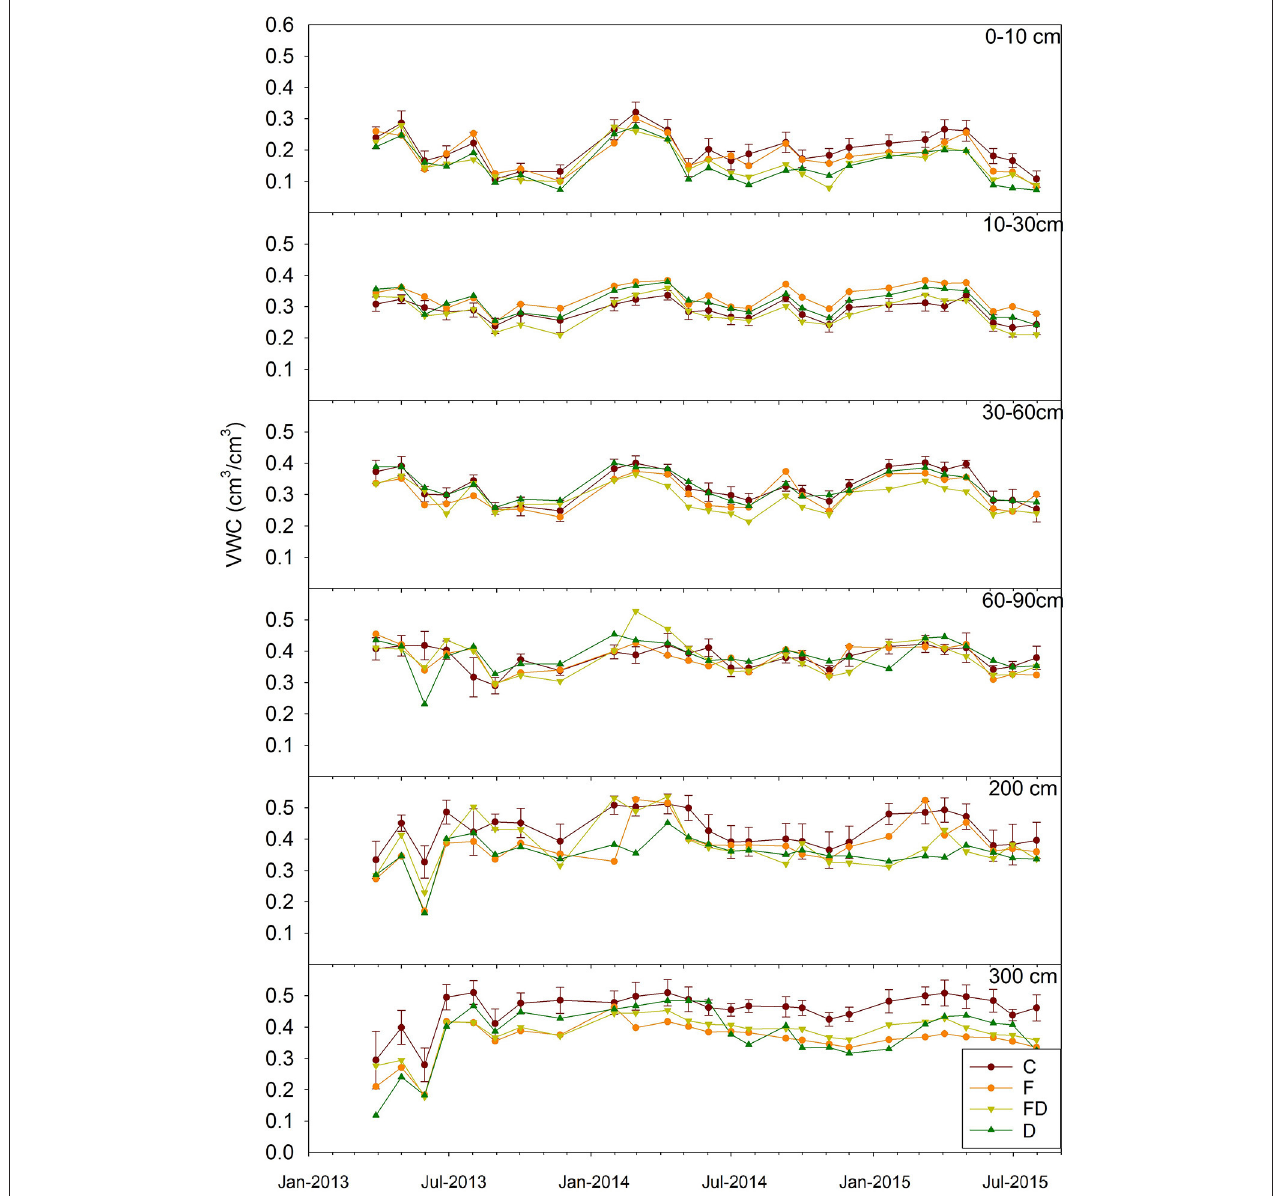
FIGURE 5 | Mean soil volumetric water content (VWC) of six depths for March 2013 to July 2015. Treatments are control (C), fertilization (F), throughfall reduction (D), and combined treatment of FD. Bars representing ± 1 SE are given only for C to maintain clarity ( n = 4).